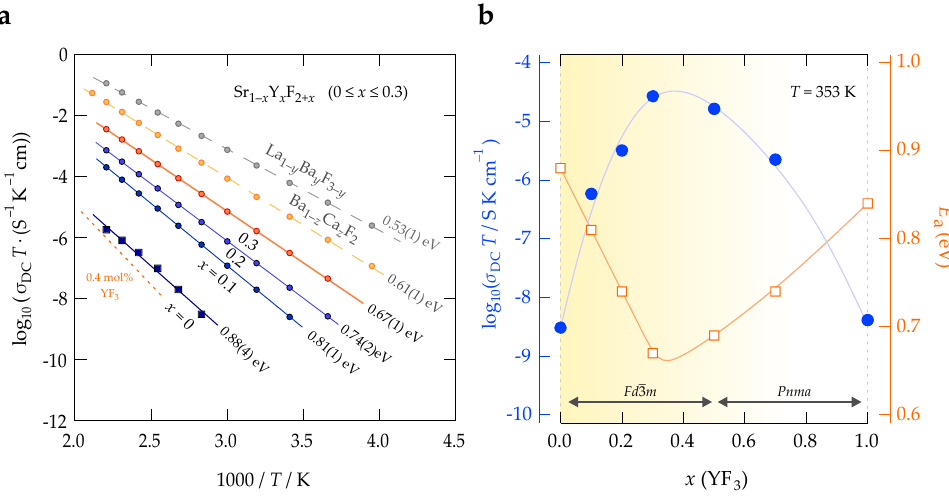
Figure 5. ( a ) Arrhenius plot of σ DC T vs. the 1/ T of mechanochemically prepared Sr 1 − x Y x F 2 + x with x ≤ 0.3. Solid and dashed lines represent fits according to an Arrhenius equation, σ DC T ∝ exp ( − E a / ( k B T )) ; k B denotes Boltzmanns constant. The activation energies obtained are indicated; ( b ) Change of E a (see right axis) and σ DC T of nanocrystalline Sr 1 − x Y x F 2 + x as a function of x . See text for further